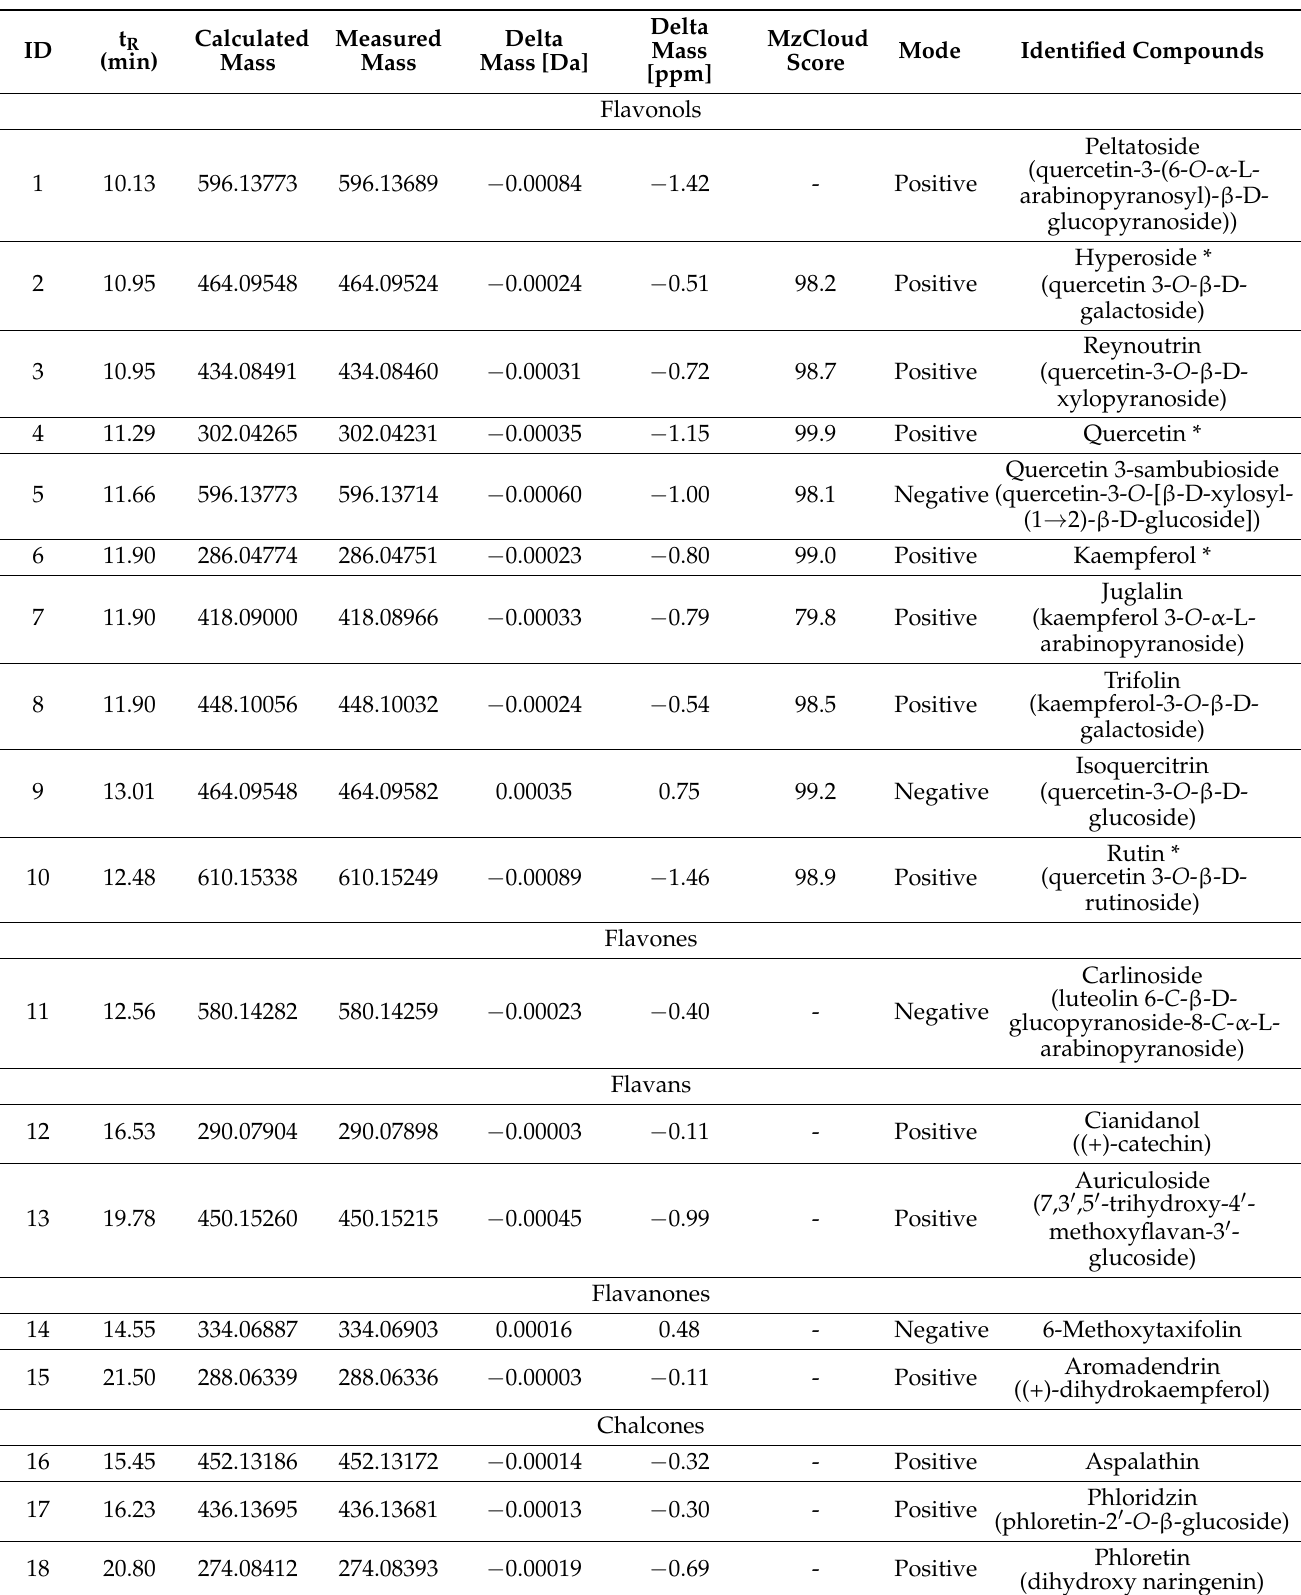
Table 1. Flavonoids identified in aqueous-ethanol extracts from E. longistipitata leaves by LC-HRMS using databases mzCloud and